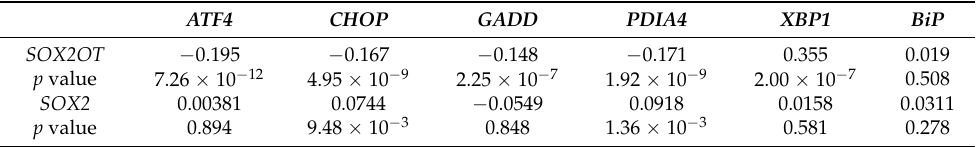
Figure 3. Heat map showing the expression of SOX2 , SOX2OT , and UPR-related genes. It shows the expression of genes in the PERK pathway ( ATF4 , CHOP / ddit3 , GADD / pp1r15a ), ENR-associ- ated degradation ( BiP / hspa5 , PDIA4 ), and the IRE1 pathway ( XBP1 ) in breast cancer samples. Data were from TCGA invasive breast carcinoma (TGCA8BRCA_exp_ HiSeqV2-2015-02-24-160222). The samples were classified based on their receptor status (oestrogen receptor (ER), HER2, or progesterone receptor (PR)). Table 1. Spearman correlation coefficients of relative gene expression for SOX2OT and SOX2 compared to the expression of genes of the UPR pathways in TGCA samples (n =